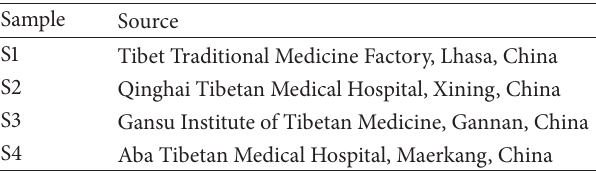
Table 1: Sources of Zuota samples.